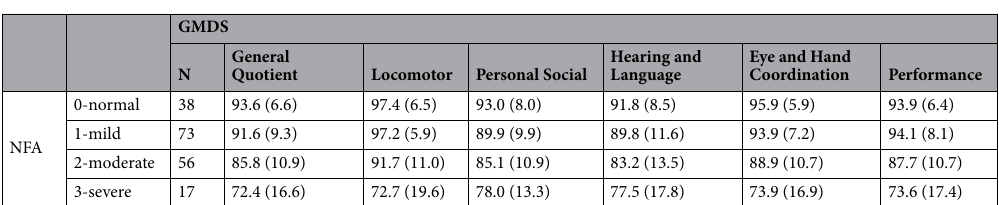
Table 3. Global quotient and subquotient mean (SD) scores at 2 years of CA according to the NFA OS at three months of CA.